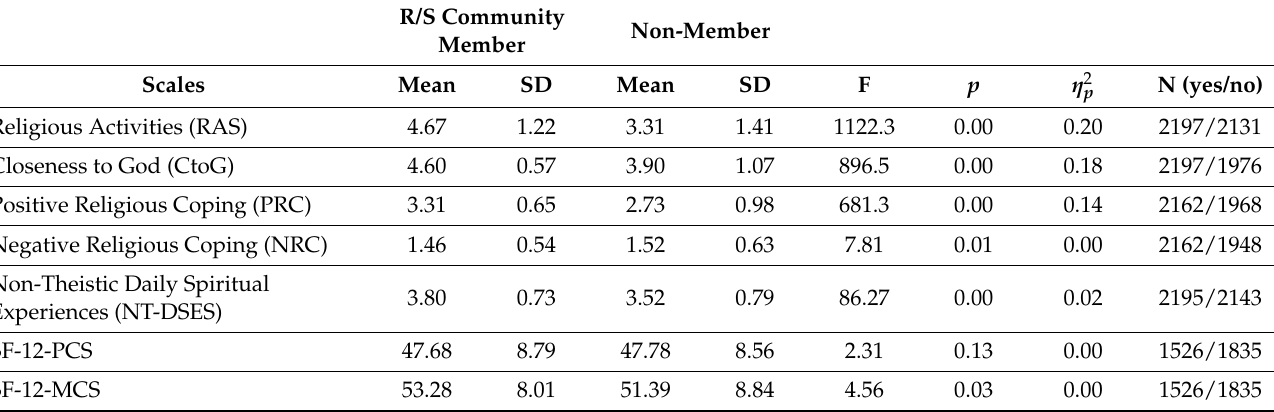
Table 5. Ability of Scales to Differentiate Meaningful R/S Subpopulations: ANCOVA for Respondents According to Membership in a Religious or Spiritual Community.